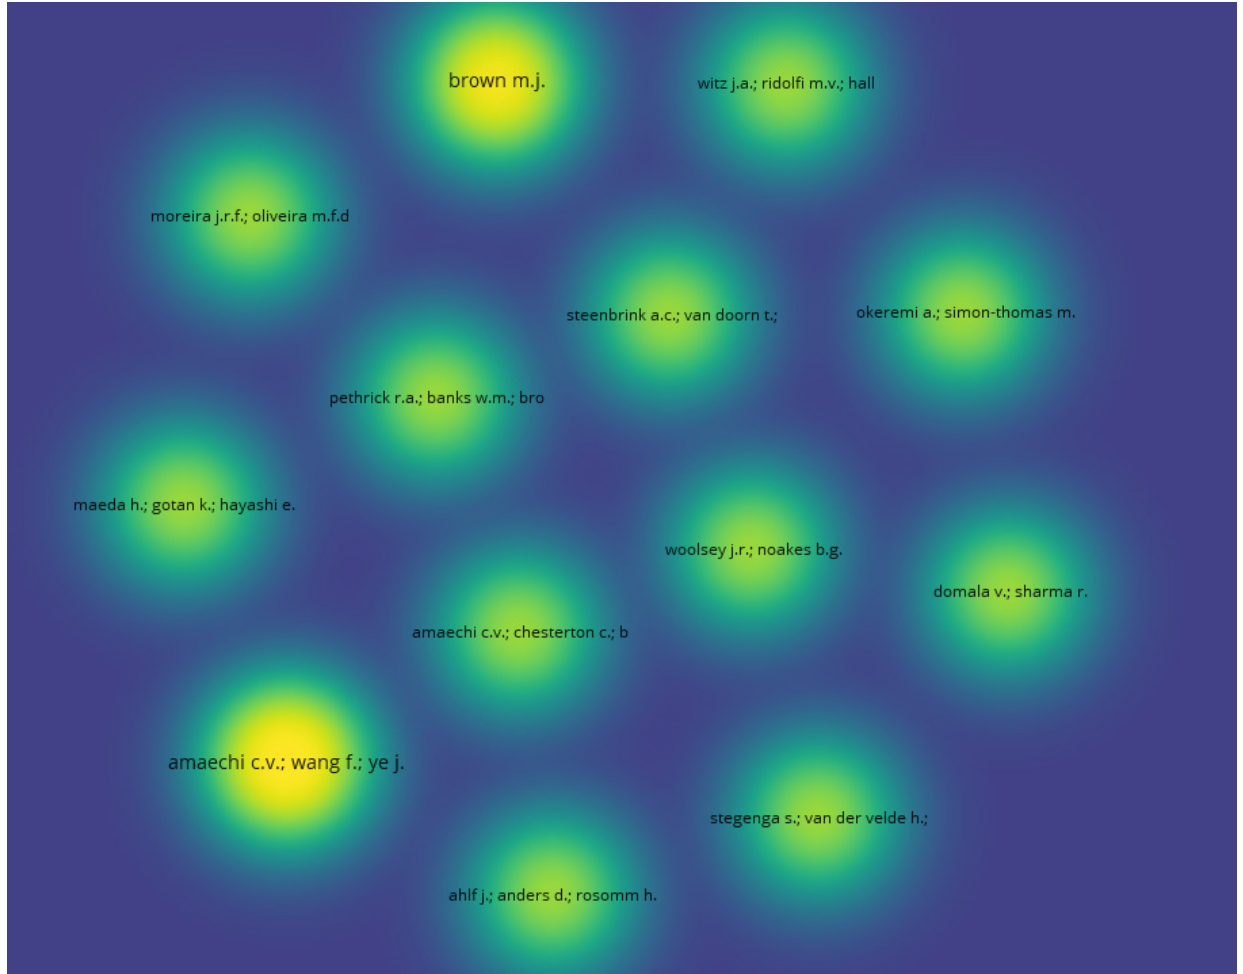
Figure 15. The density visualization map on co-authorship for the research on “marine hose using VOSviewer (data retrieved from Scopus database, 24 July 2022).